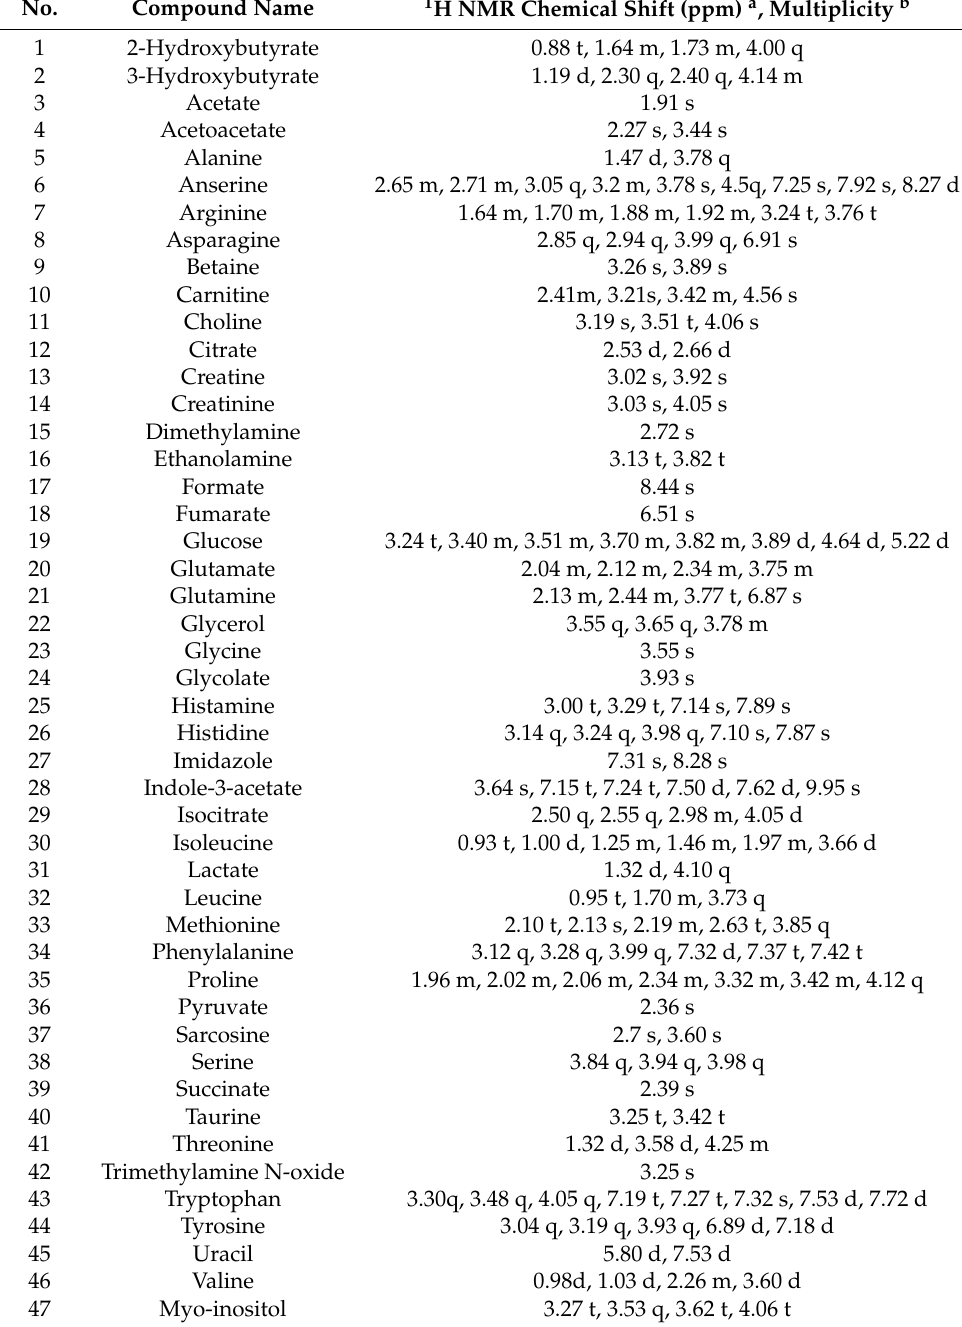
Table 1. Chemical shift and multiplicity of the metabolites (putatively annotated compounds using Chenomx NMR Suite 8.3 software) of 1D 1 H NMR spectra of the polar extract of serum of lesser scaup ( Aythya affinis ) implanted with CORT or placebo pellets. No. Compound